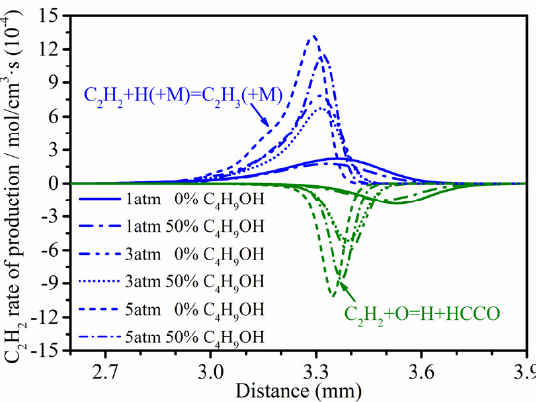
Figure 10. Rate of production of C 2 H 2, with different levels of n -butanol at different pressures.